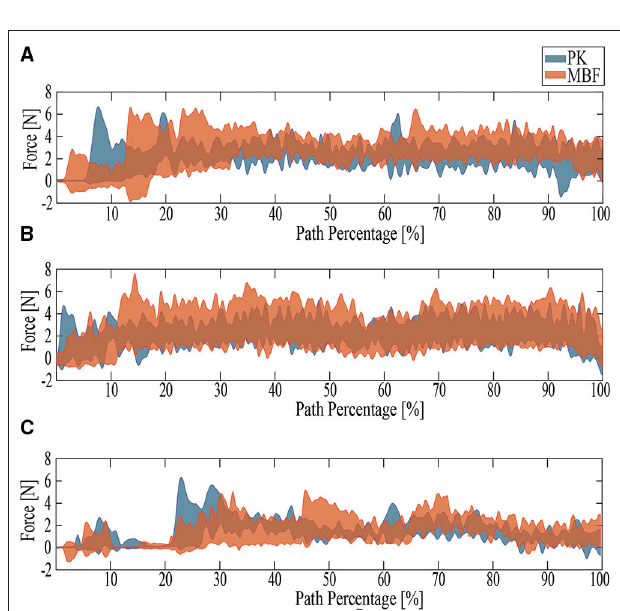
FIGURE 8 | The behavior of the results obtained for force. PK stands for older adults with PD and MJF stands for a group of older adults with base, joint, and fracture diseases. (A) RUT. (B) RDT. (C) TUGT.